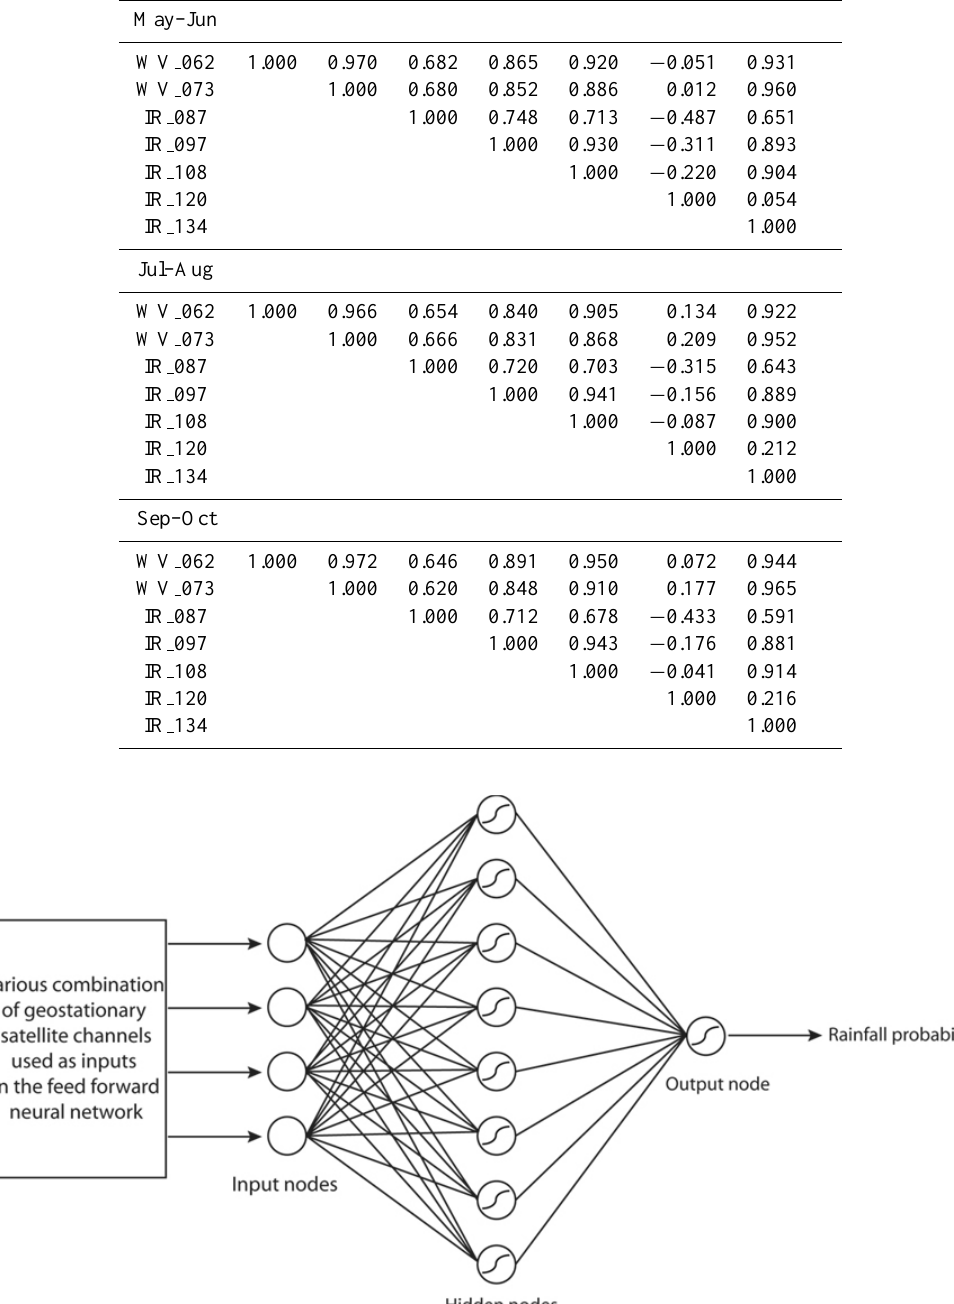
Table 2a. Correlation matrices for three periods.